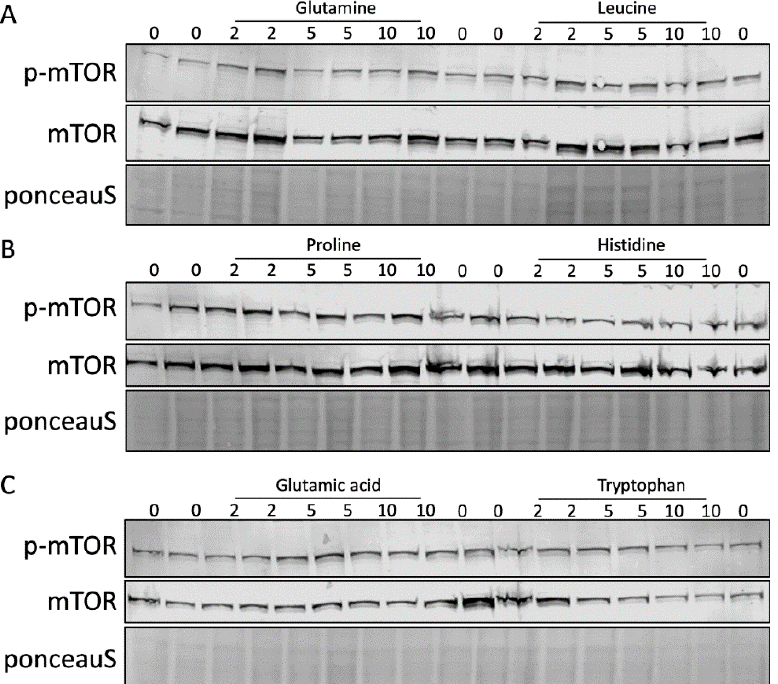
Figure 5. The amino acids do not increase mTOR activity. HepG2 cells were treated with 0–10 mM of six different amino acids for 48 h. mTOR expression and activation was determined by western blotting using mTOR and p-mTOR antibodies with p-mTOR reflecting activated mTOR. Effects of ( A ) glutamine, leucine, ( B ) proline, histidine, ( C ) glutamic acid, and tryptophan. This experiment was performed twice with each condition in duplo.